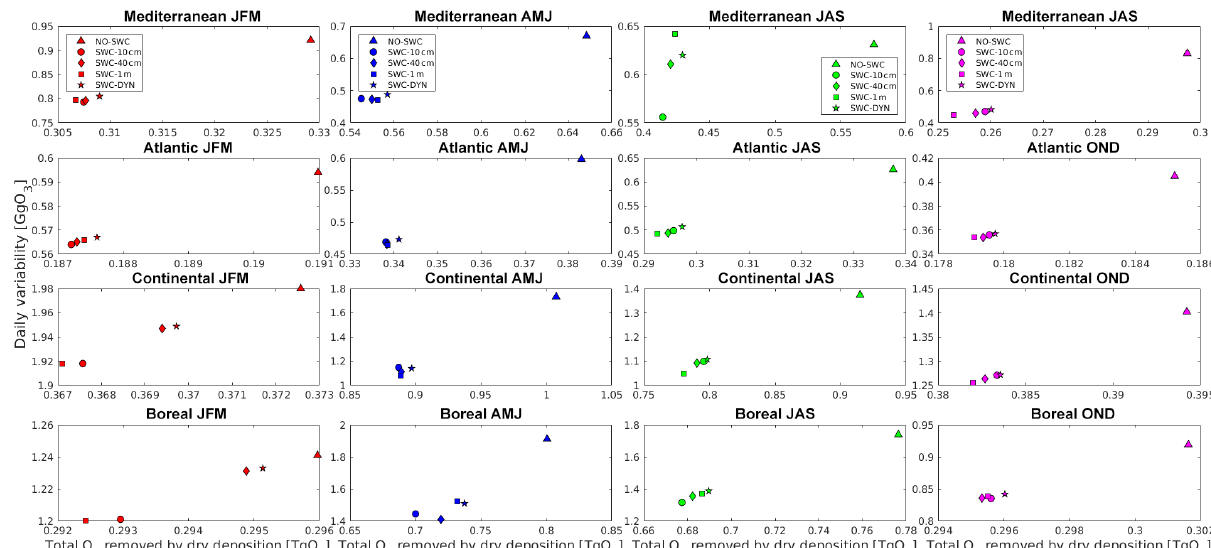
Figure 3. Comparison of seasonal amount of O 3 removed by dry deposition spatially integrated over climatic regions (https://www.eea. europa.eu/data-and-maps/data/biogeographical-regions-europe-3, last access: 20 April 2018) along with standard deviation of daily